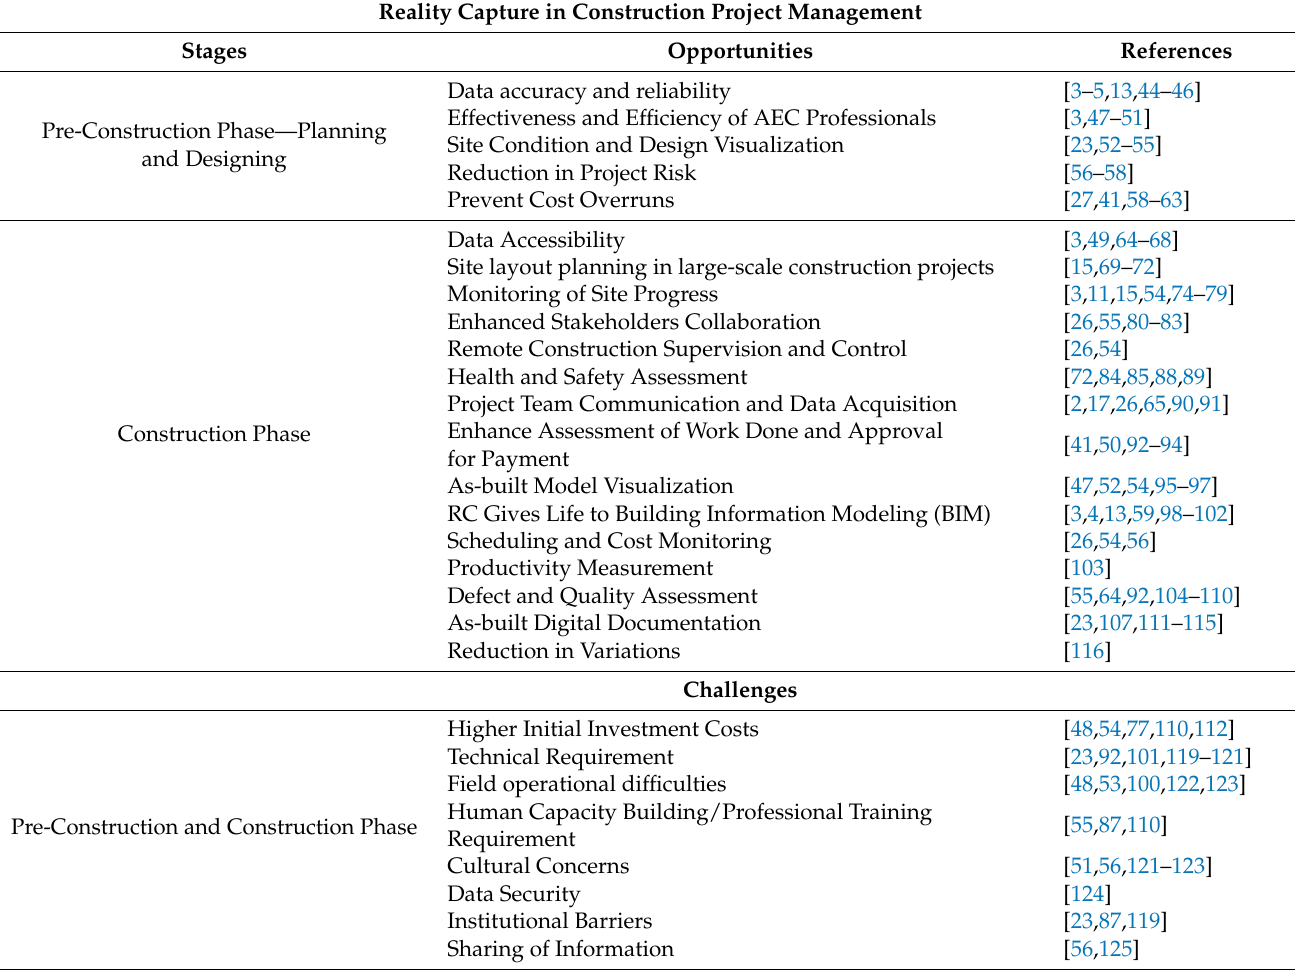
Table 1. Summary of Opportunities and Challenges using Reality Capture in Construction